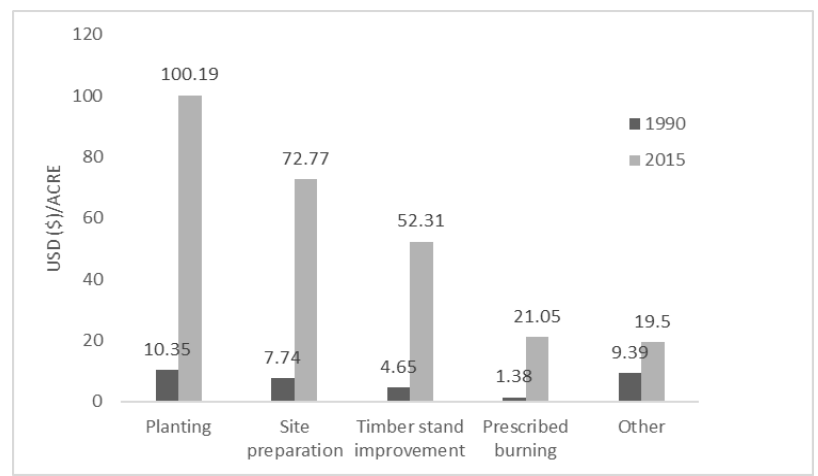
Figure 5. Mean expenditures for Timber Management Activities of the entire sample .